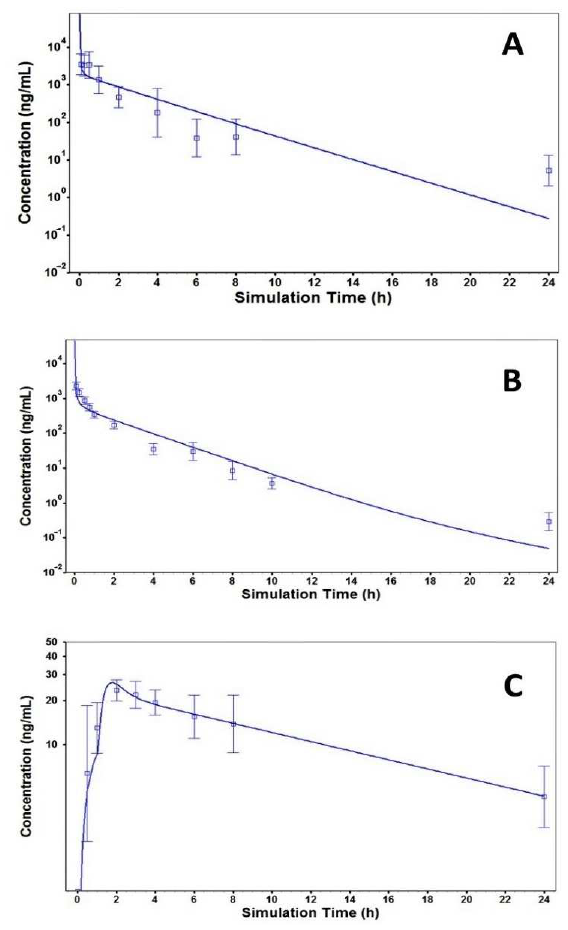
Figure 8. Simulated and observed plasma concentration results of Matr in mouse (2.8 mg/kg i.v., panel ( A )), rat (2.0 mg/kg i.v., panel ( B )) and human (2.6 mg p.o., panel ( C )) with PBPK model .